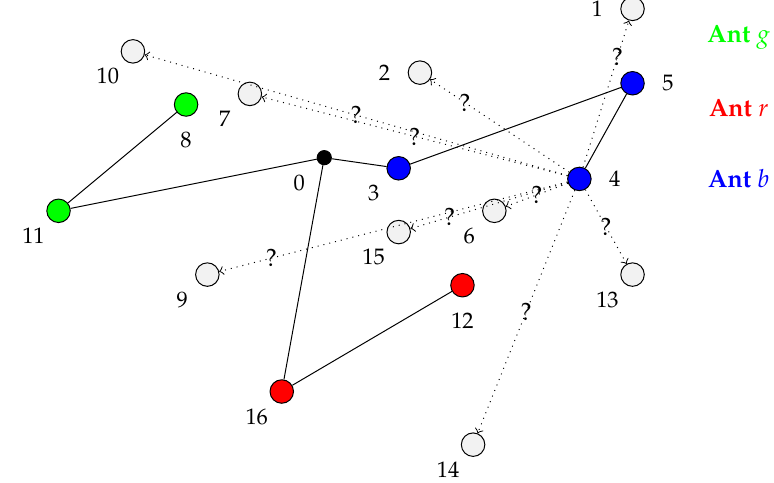
Figure 4. One state example of the ant-picket